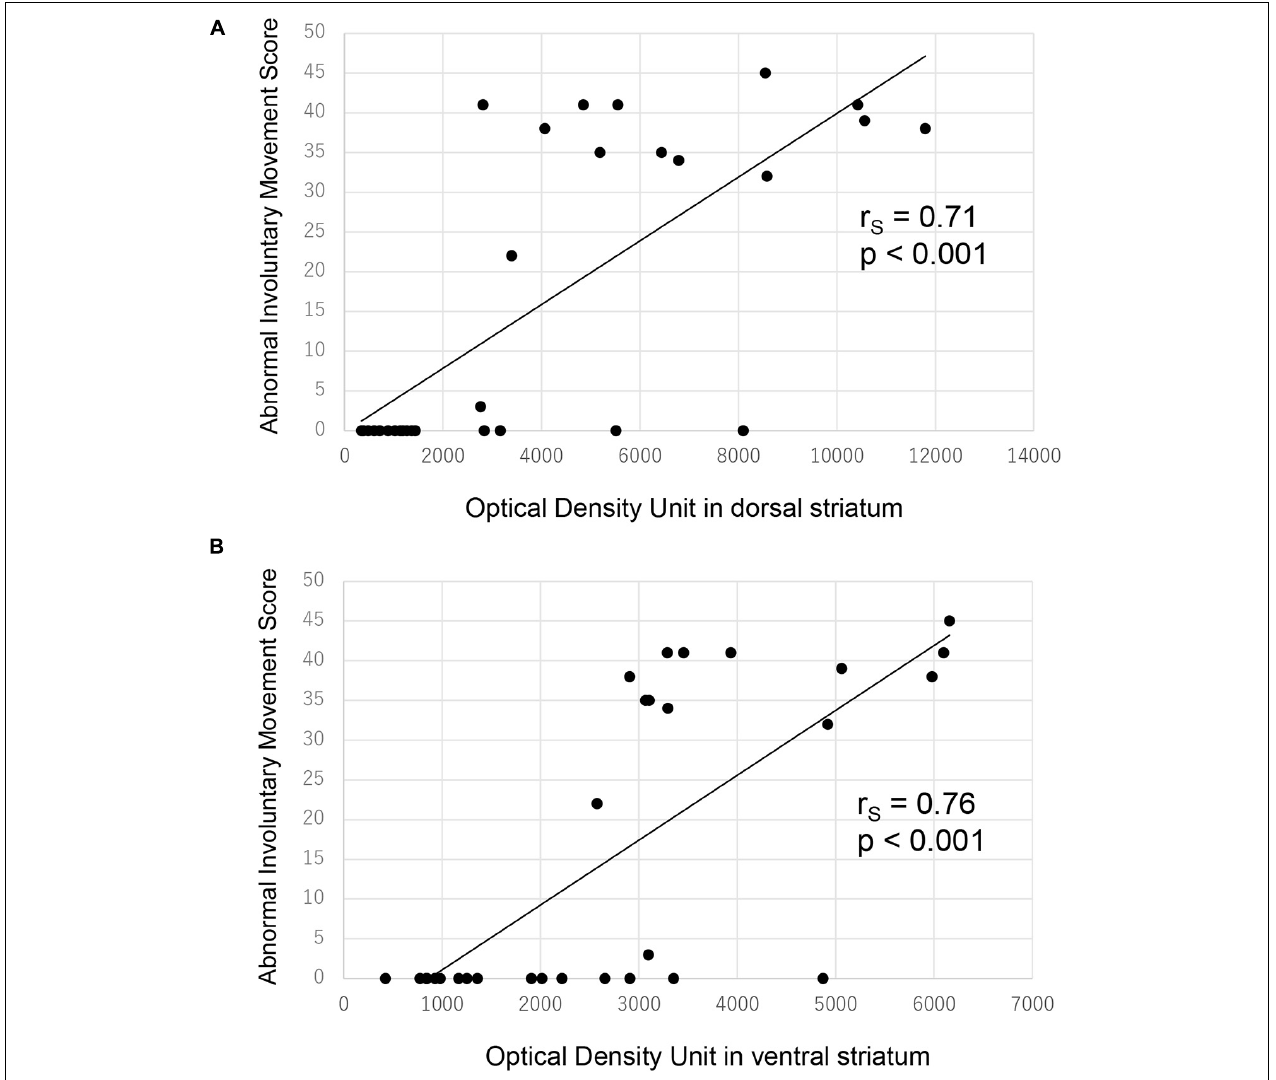
FIGURE 4 | Correlation between ALO AIM score and preprodynorphin mRNA expression for all rats. There was significant correlation between ALO AIM score and preprodynorphin mRNA expression in the dorsal (A) and ventral (B) striatum. ALO AIM score, sum score of axial, forelimb, and orolingual scores; r S , Spearman’s rank correlation coefficient.